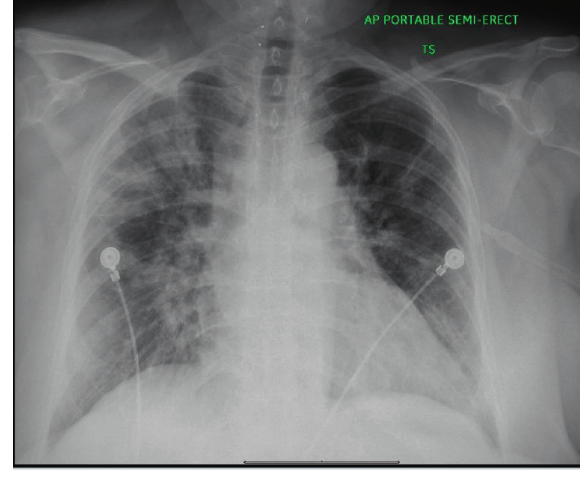
Figure 2: Chest X-ray showing an improvement in bilateral